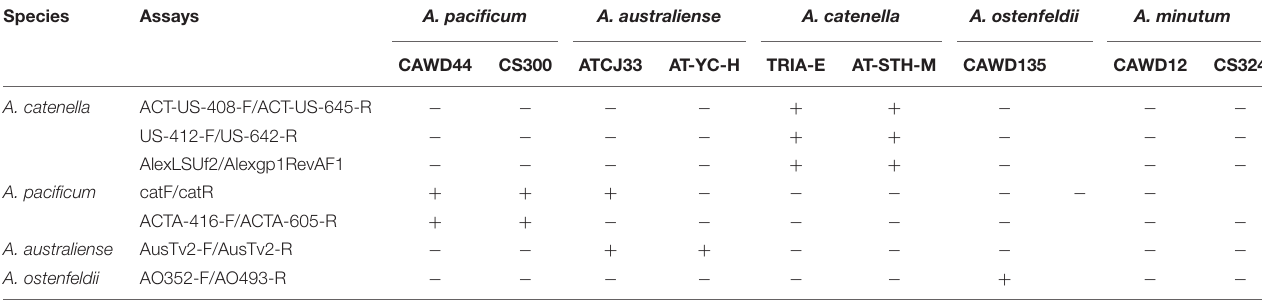
TABLE 3 | Specificity of Alexandrium qPCR Assays.